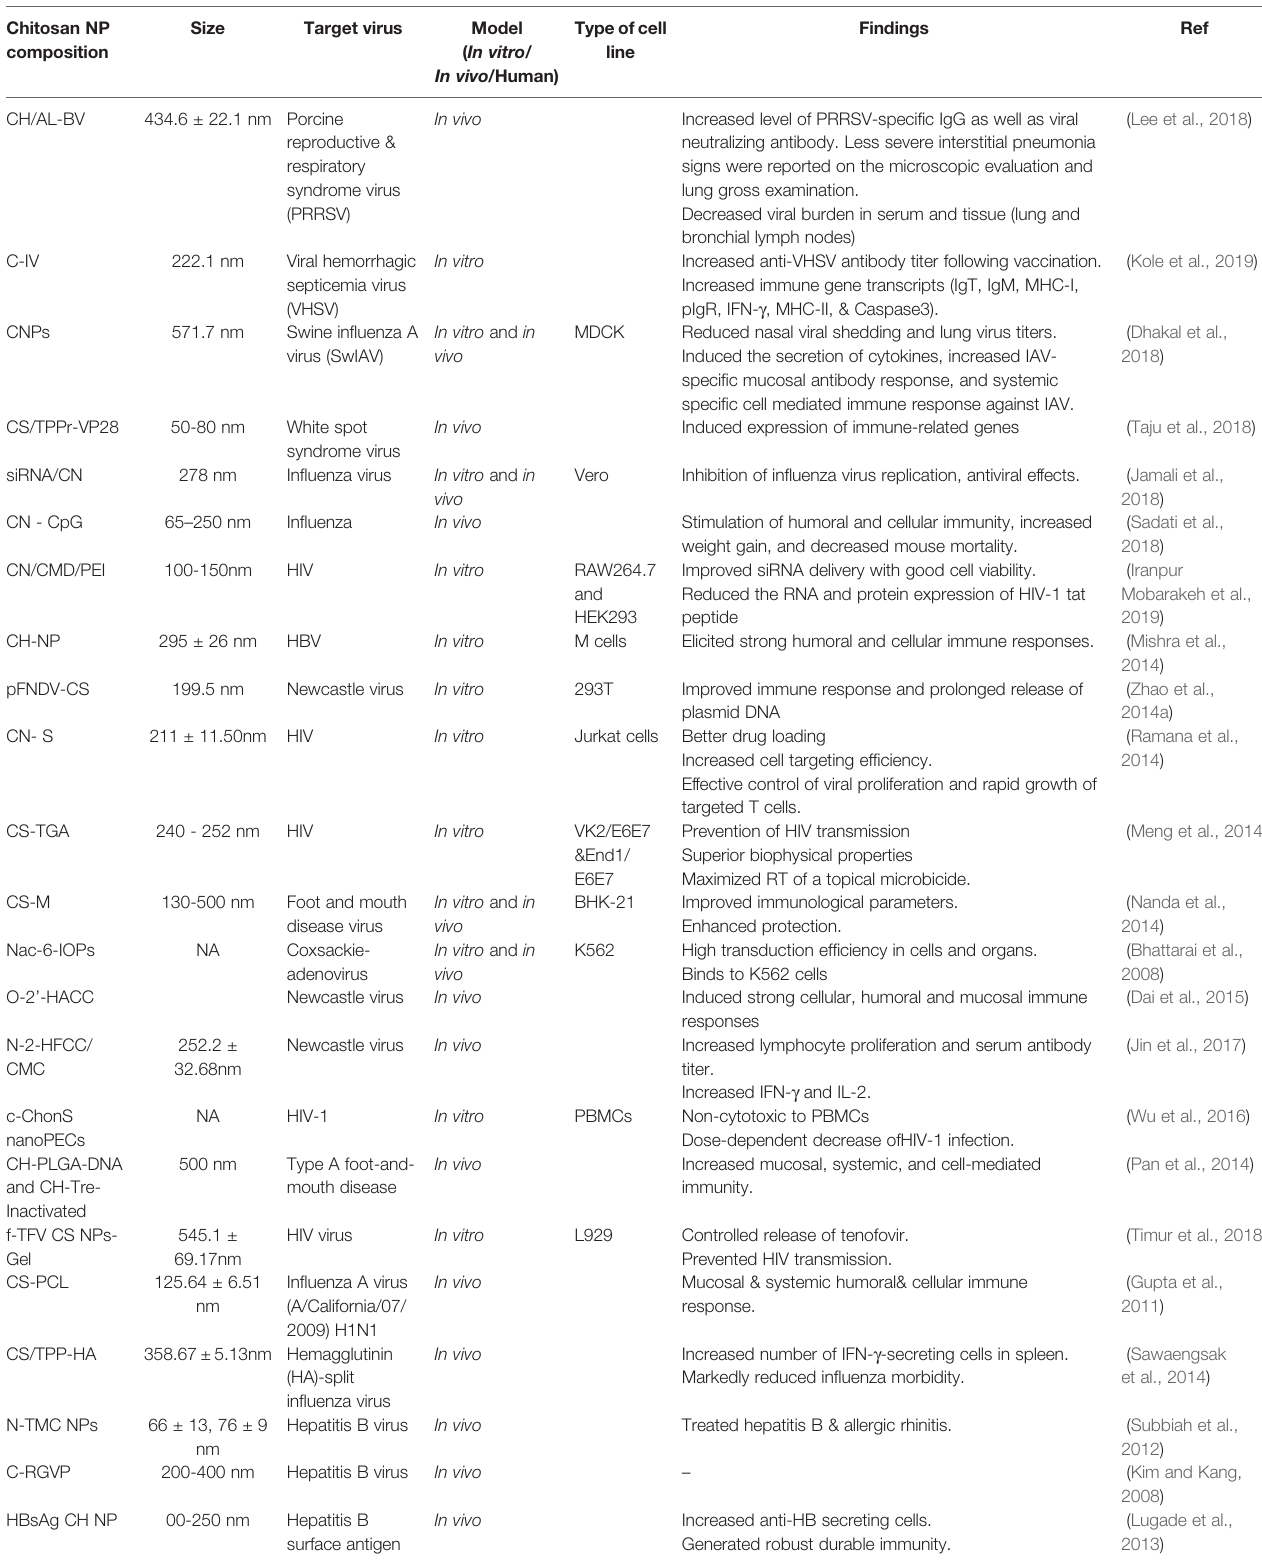
TABLE 1 | Chitosan nanoparticles used as drug delivery systems for viral infections. Chitosan NP